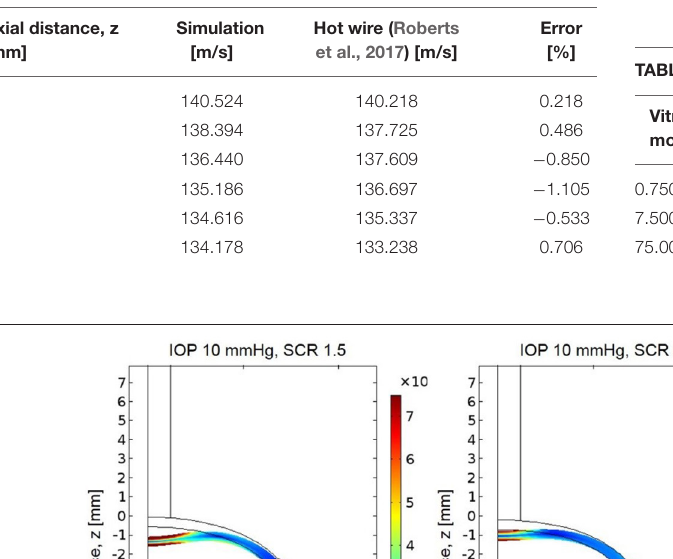
TABLE 4 | Spatial measurements of air flow velocity along axis of symmetry at peak pressure.